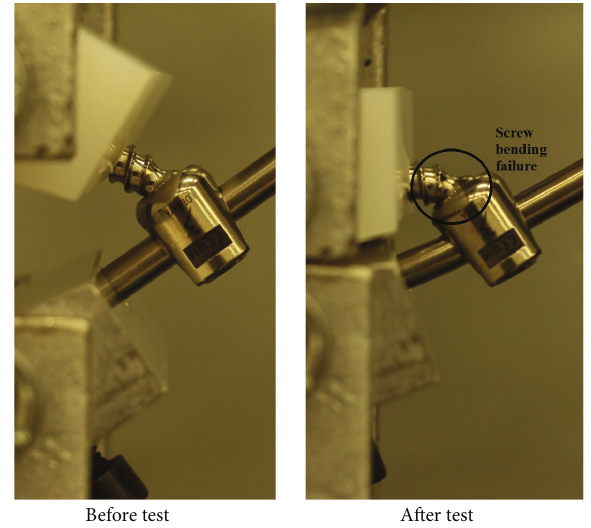
Figure 9: Screw bending failure in flexion moment test, before and